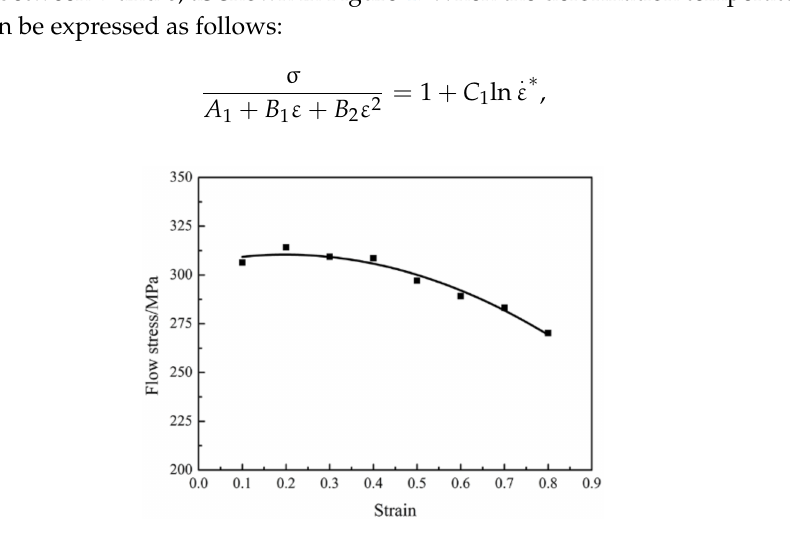
Figure 4. The relationship between stress and strain at 800 ◦ C and 1 s − 1 .